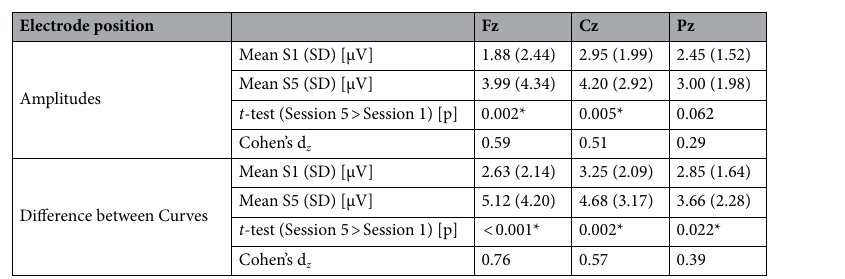
Table 1. Statistics for physiological measures at Fz, Cz and Pz. Values extracted from grand averages of EEG data. Asterisks indicate significance.